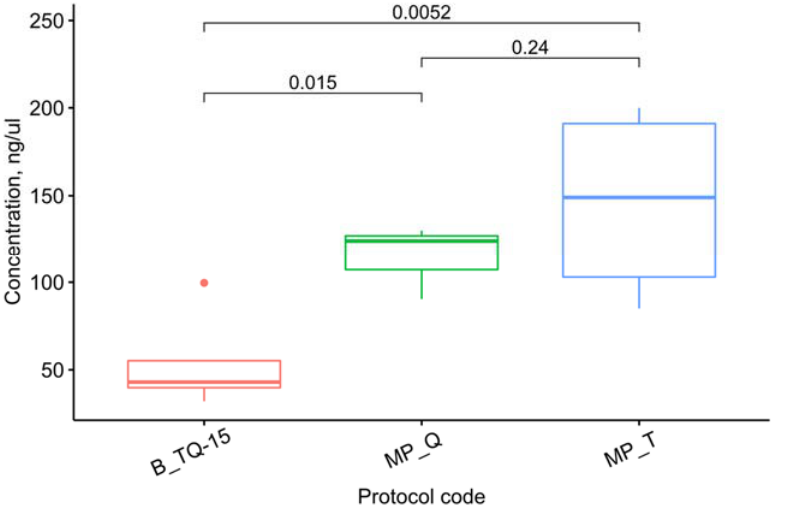
Figure 5. Pairwise comparison of the concentrations obtained by the three methods with the highest average RIN. The letters up to “_” denote the grinding method: MP–mortar and pestle, NB–Tissue Lyser without buffer, and B–with buffer. The following letters denote the isolation protocol: T–TRIzol, Q–RNEasy Plant Mini Kit, and TQ–a combination (Table 1). The number after “-” denotes the grinding time on the Tissue Lyser in seconds. The t -test p -values are given for each pair of methods. Dots represent outliers.